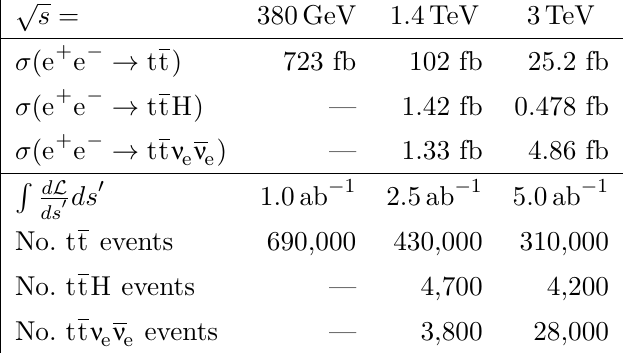
Table 2. Unpolarised cross sections for tt, ttH and tt n production assuming m = 174 GeV e n e t and m = 125 GeV at the three centre-of-mass energies studied in this paper. The numbers for H 380 GeV include QCD corrections (see text) while leading-order results are given for the higher p energy stages. s 0 is the e(cid:11)ective centre-of-mass energy of the e + e (cid:0) collision. The presented cross sections include the e(cid:11)ects of ISR but not the e(cid:11)ects of beamstrahlung. Also given are numbers of expected events, including both e(cid:11)ects. The presented event numbers include the assumptions on electron beam polarisation described in subsection